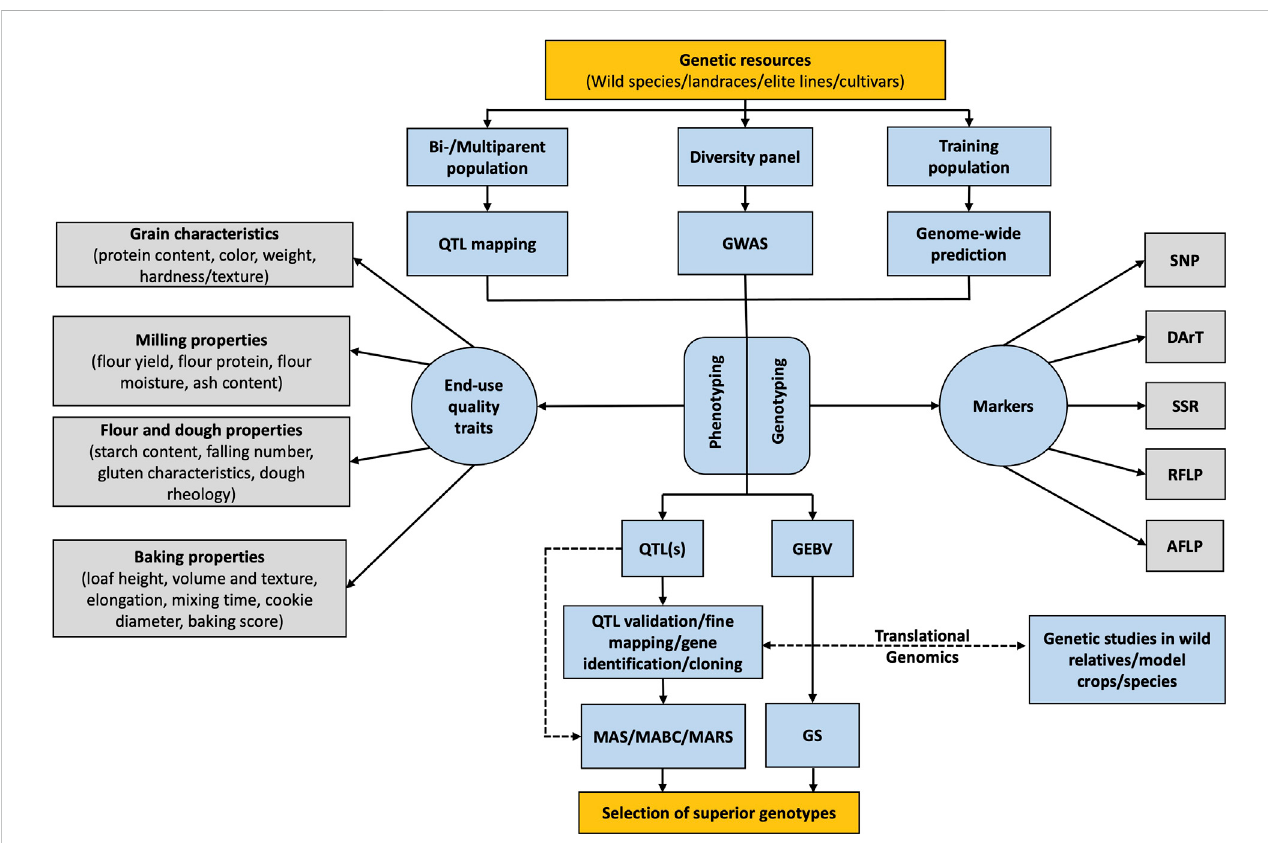
FIGURE 1 Schematic fl ow diagram showing the use of genomics-assisted breeding and translational genomics for improvement of end-use quality traits in wheat breeding program.